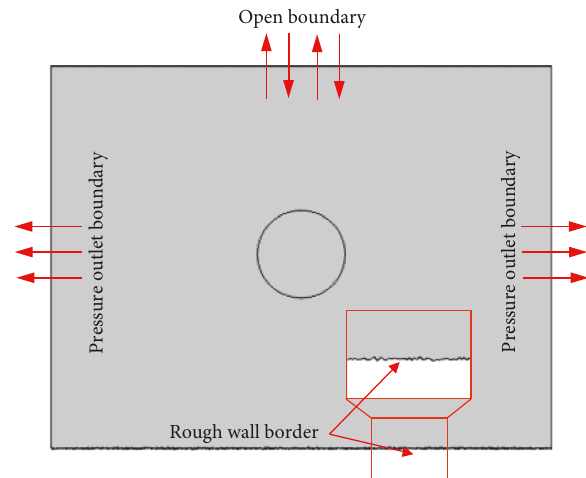
Figure 4: Physical model of droplet-wall